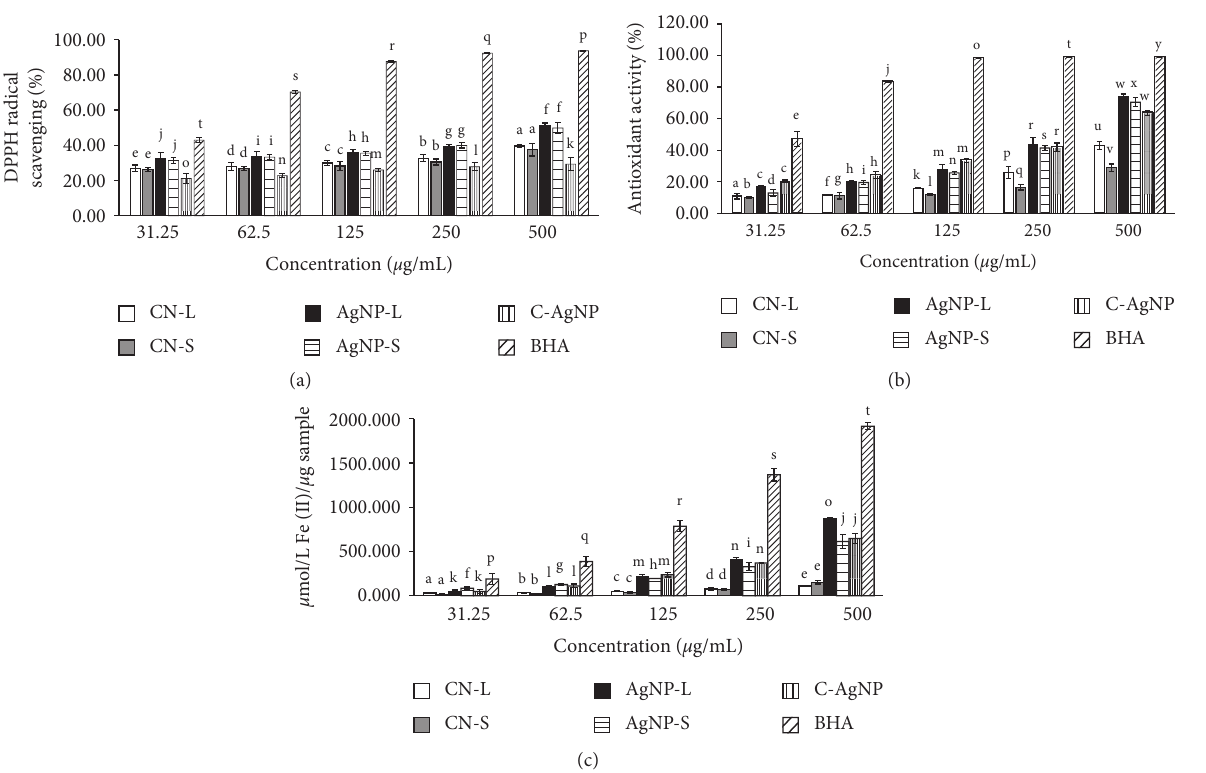
Figure 1: (a) DPPH, (b) ABTS, and (c) FRAP assays. Samples with different lower case superscript letters differ significantly ( p < 0.05) between them (mean ± SD, n �